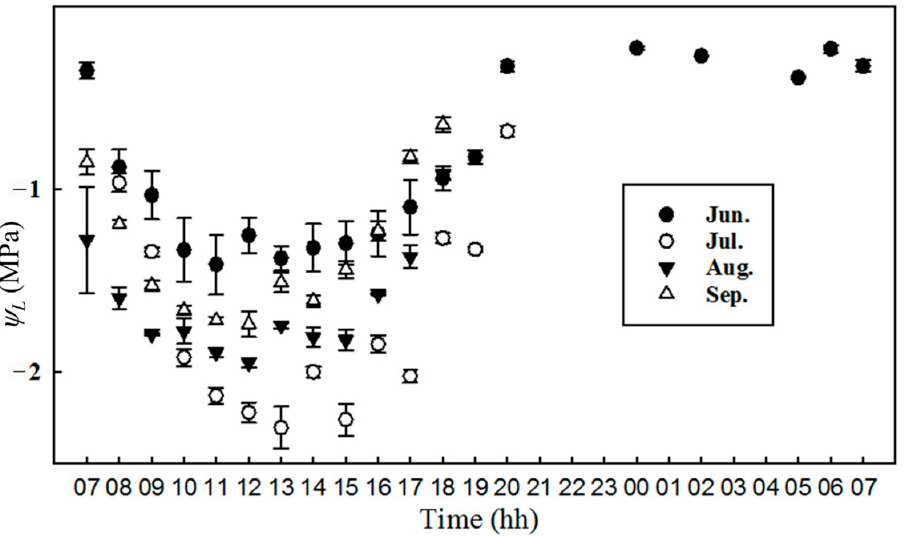
Figure 5. Diurnal variations in leaf water potential ( ψ L ) from June to September in 2014. Data were collected over 1 to 2 days of measurements in each month.